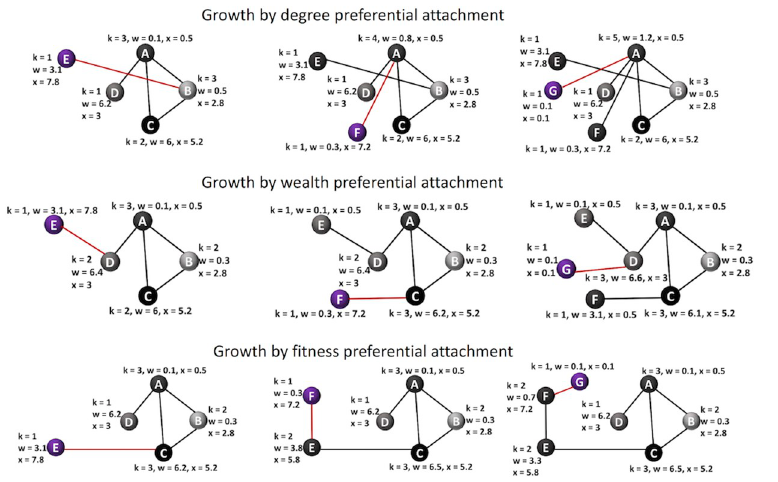
Fig 9. Illustration of the growth of toy network based on various attachment mechanisms.